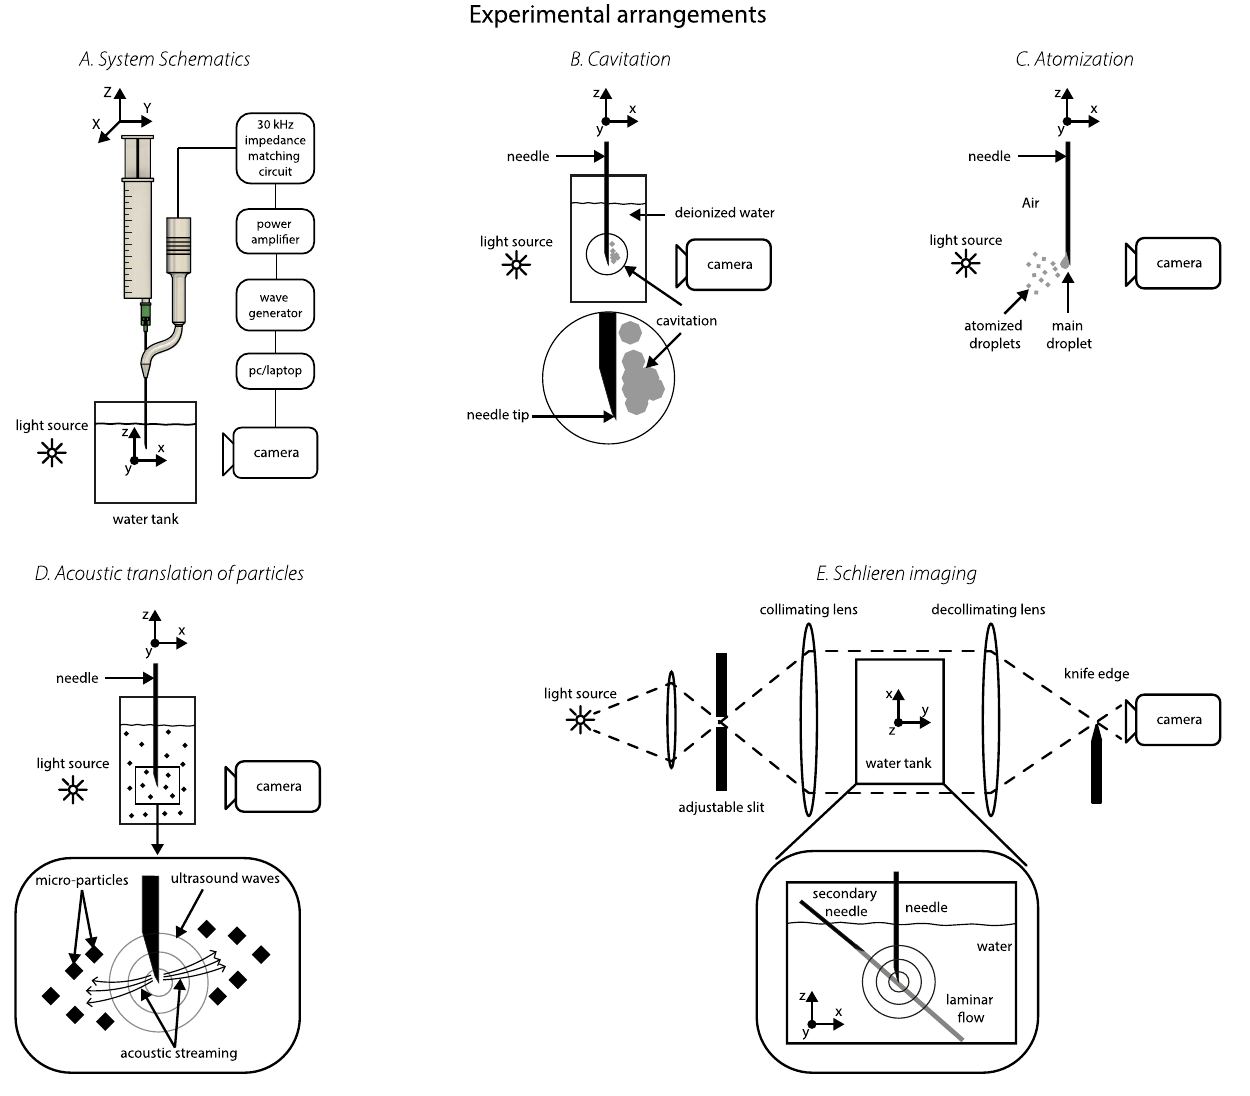
Figure 6. Experimental arrangements: ( A ) Simplified schematics of the ultrasound system arrangement with optical detection of needle tip activity, ( B ) cavitation experiment, ( C ) atomization experiment, ( D ) acoustic streaming experiment and the ( E ) Schlieren imaging